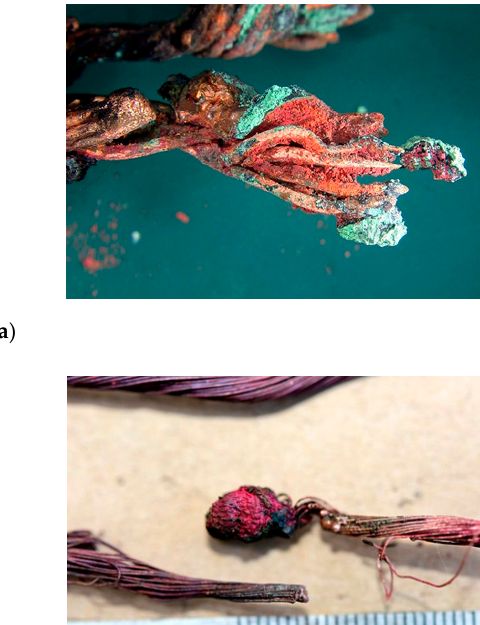
Figure 4. Power distribution system on shipboards. ( a ) photograph; ( b ) diagram.